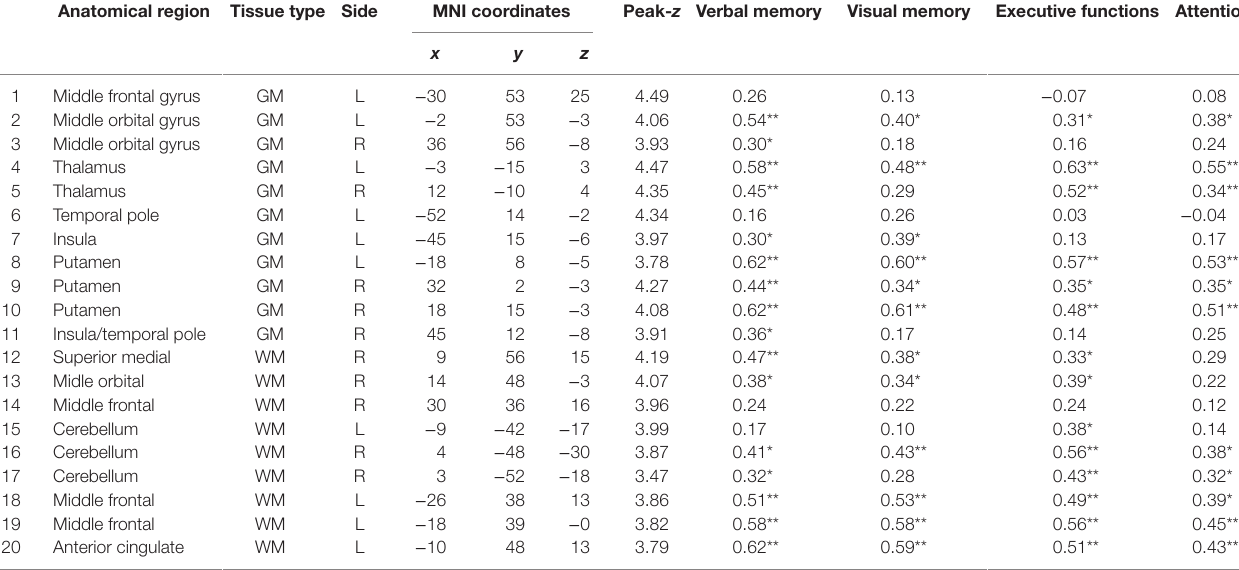
TaBle 3 | Brain regions with significantly less gray matter and white matter volume in the TBi compared to control group and their Pearson product-moment correlations with neurocognitive measures. anatomical region Tissue type